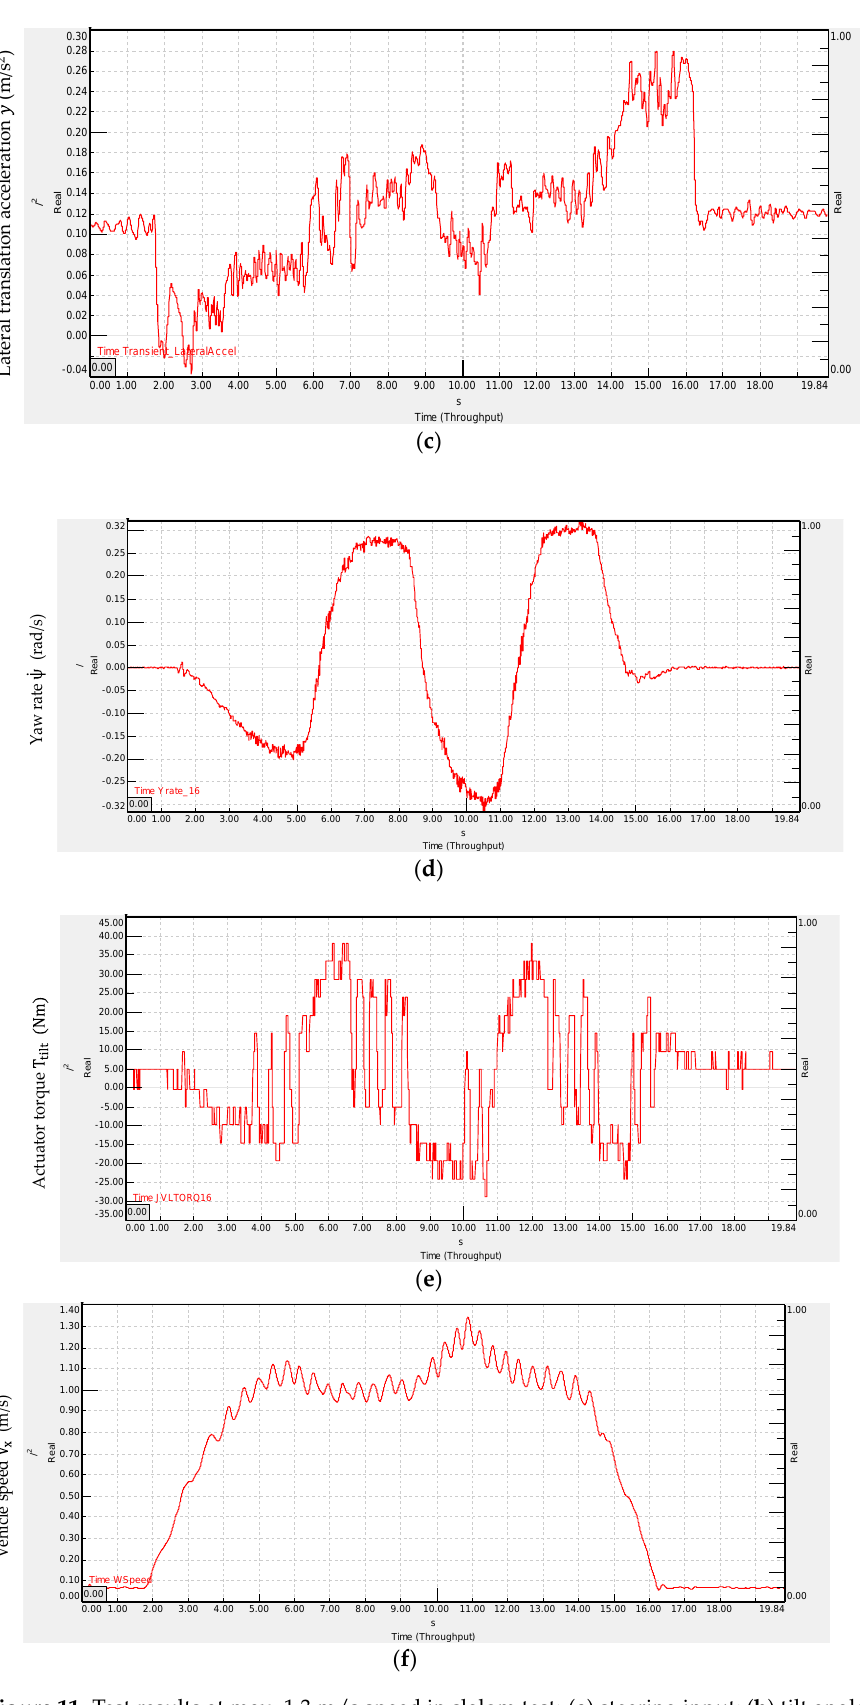
Figure 11. Test results at max. 1.3 m/s speed in slalom test: ( a ) steering input; ( b ) tilt angle; ( c ) lateral translation acceleration; ( d ) yaw rate; ( e ) actuator torque; and ( f ) vehicle speed.